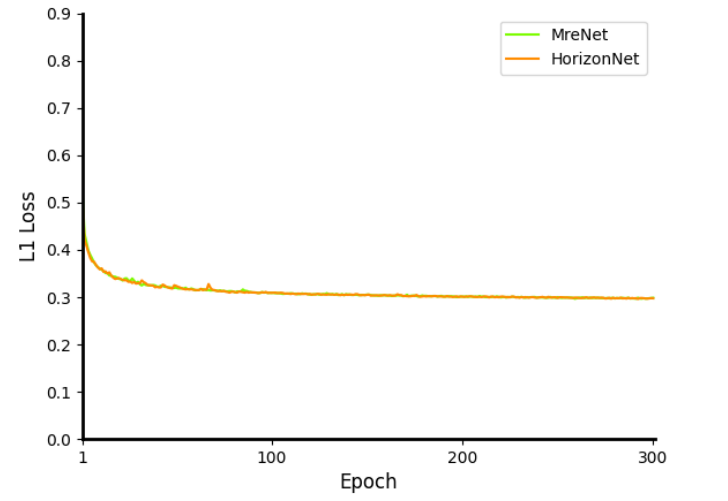
Figure 4. Convergence behavior of MreNet and